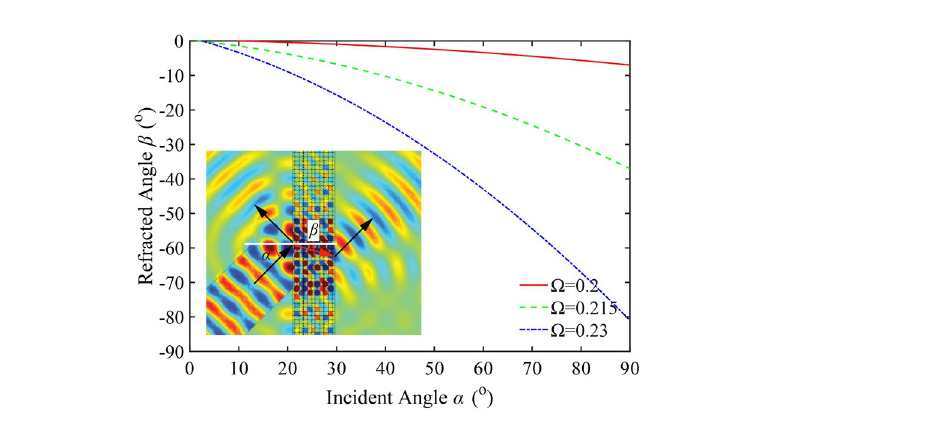
Figure 4. The refracted angle as a function of incident angle at different normalized frequencies. The inset is simulation result for a plane wave through a 10-layer PnC slab with incident angle 45° at frequency Ω =